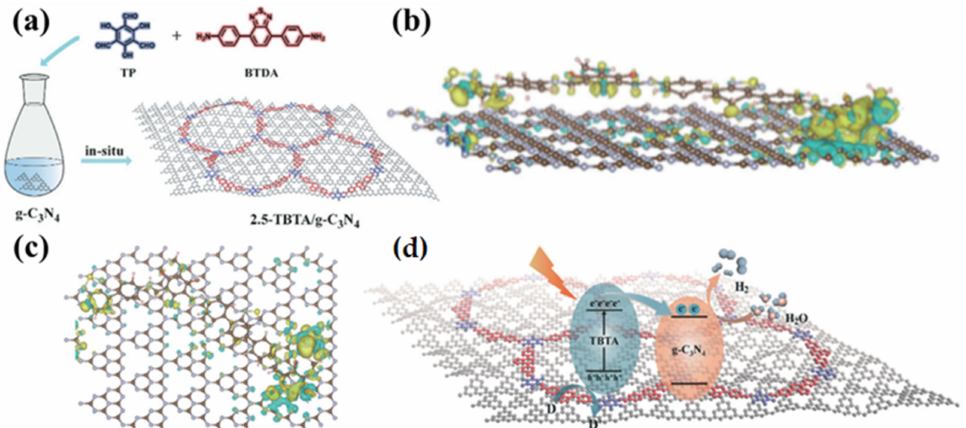
Figure 10. ( a ) The synthesis of the 2.5-TBTA/g-C 3 N 4 hybrid. ( b , c ) Charge density differences in the constructed cluster model of TBTA/g-C 3 N 4 (blue: accumulation region; yellow: depletion region). ( d ) The possible photocatalytic mechanism. Reproduced with permission frrom Ref. [51]. Copyright: Royal Society of Chemistry,